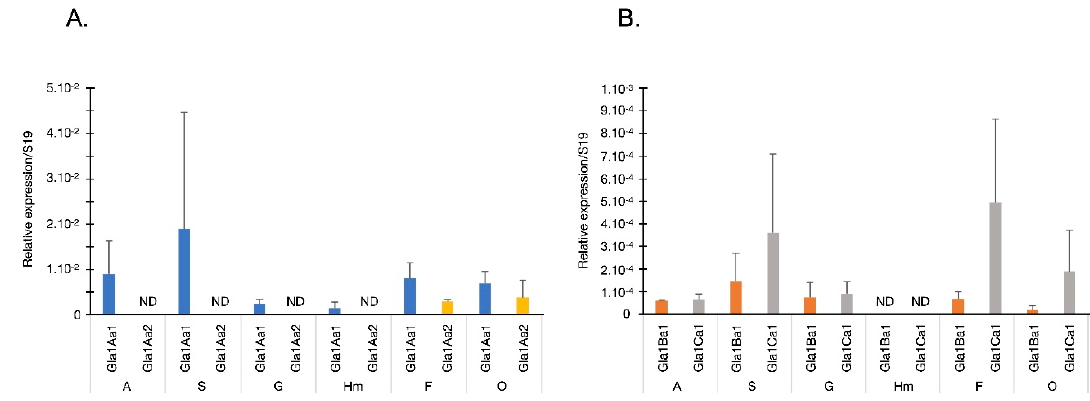
Figure 6. Tissue expression pattern of Glabralysins. Gene expression was quantified by RT-QPCR for Gla1Aa1 and Gla1Aa2 ( A ) and Gla1Ba1 and Gla1Ca1 ( B ). Data represent mean and standard deviation normalized expression to the S19 ribosomal protein-encoding gene. Tissues are annotated as follows: A, albumen gland; S, stomach; G, gut; Hm, hemocytes; F, head-foot; and O, ovotestis. ND: Not Detected. Expression is considered as ND when no amplification was obtained or if less than four biological replicates were